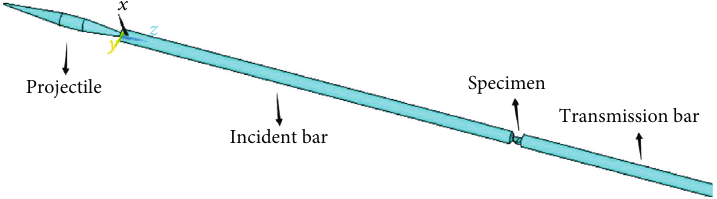
Figure 2: SHPB three-dimensional full-bar model.